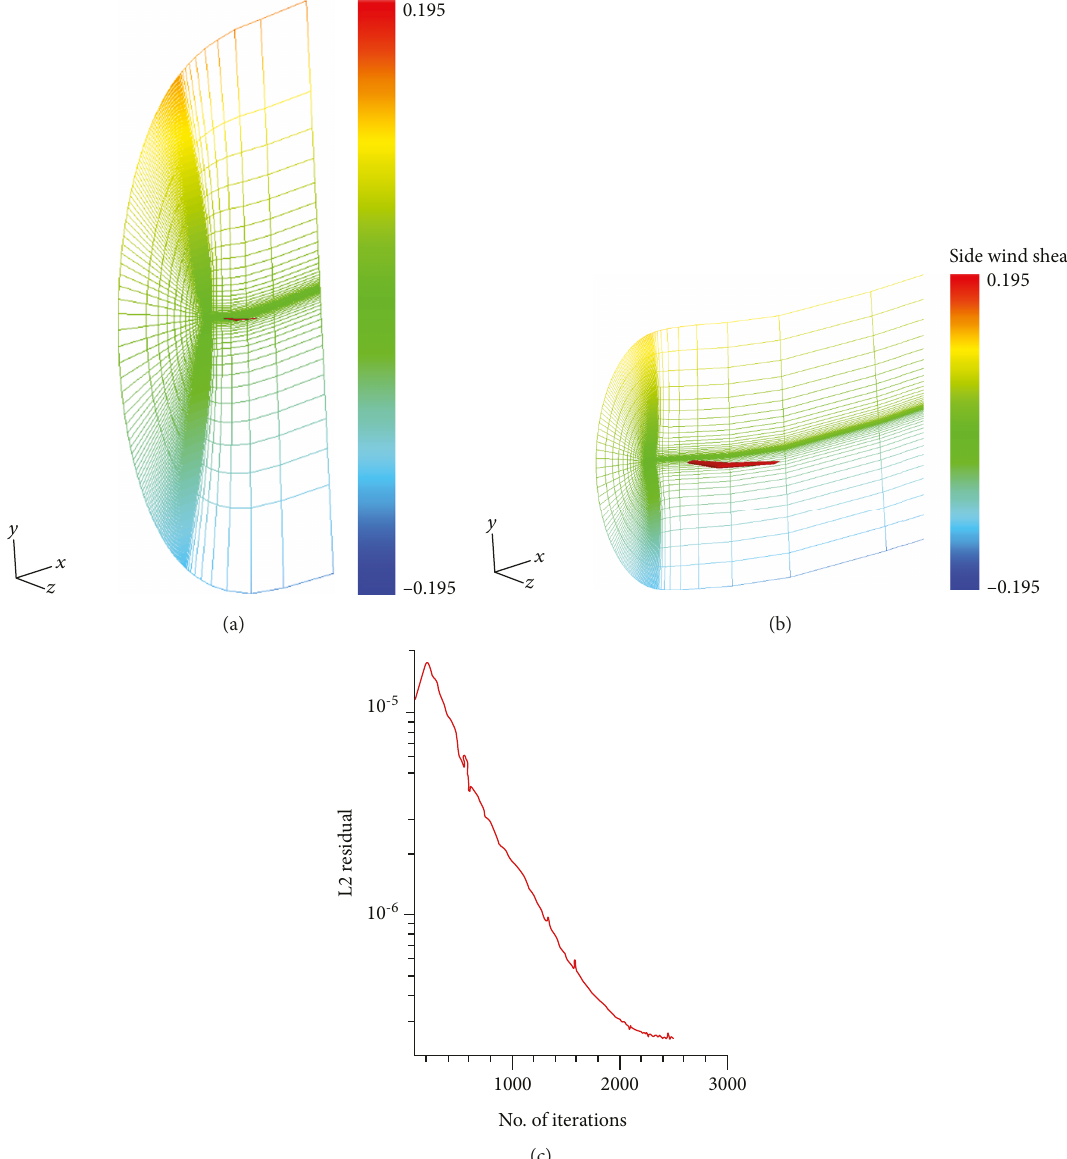
Figure 10: Wind shear at the far starboard boundary with the 3D wing in the